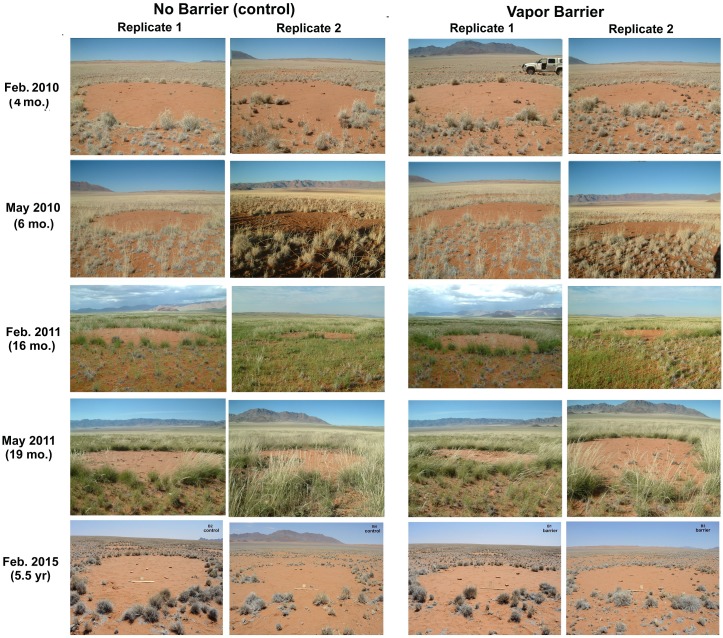
The appearance of the barrier experiment circles from Feb. 2010 until Feb. 2015.Presence of the vapor barrier 30 cm below the surface did not cause revegetation. There is no evidence that subterranean vapors or gasses are the cause of the bare circles.